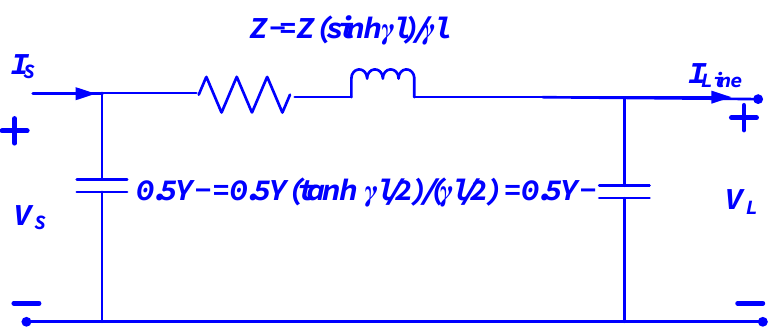
Figure 5. Modified π equivalent circuit of Underground Cable (UGC).